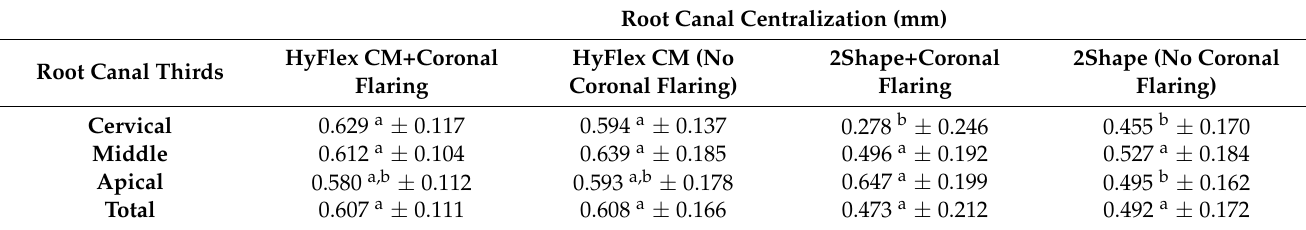
Table 2. Means (mm, millimeters) ± standard deviations of root canal centralization with the different instrumentation procedures for each root canal section.